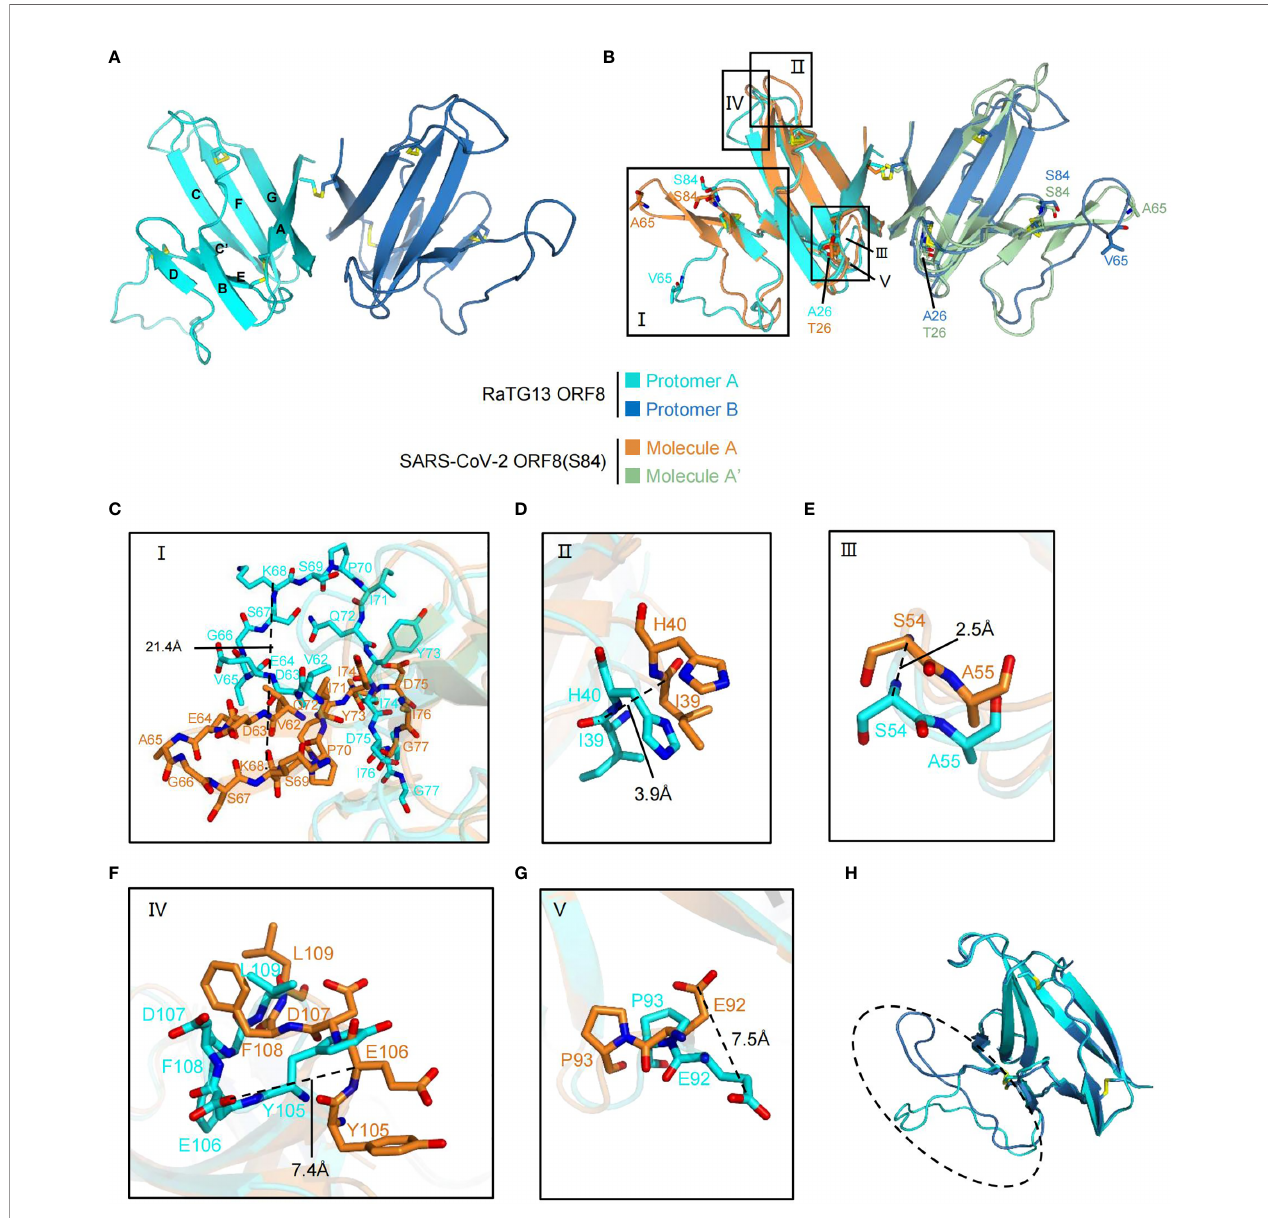
FIGURE 2 | Comparison of RaTG13 ORF8 with SARS-CoV-2 ORF8 (S84). (A) Cartoon representation of the homodimer of RaTG13 ORF8 formed by Cys20 - Cys20 intermolecular disul fi de bond. Protomer A is colored with cyan, and Protomer B is colored with blue. Disul fi de bonds are presented in yellow with stick mode. The b -strands of protomer A are assigned with the alphabet from N-terminus to C-terminus. (B) Structural superimposition between RaTG13 ORF8 and SARS-CoV-2 ORF8 (S84). The diverse residues are shown with stick model and corresponded color. The structural differences of loops are shown in black boxes indicated with Roman numbers I to V. Box I, residues from 62 to 77; box II, residues from 39 to 40; box III, residues from 54 to 55; box IV, residues from 105 to 109; box V, residues from 92 to 93. (C – G) Details of structural differences from the superimposition of SARS-CoV-2 ORF8 (S84) molecule A and RaTG13 ORF8 protomer A. (H) Structural alignment between protomers A and B of RaTG13 ORF8. The residues 63 - 78 are highlighted in the dashed